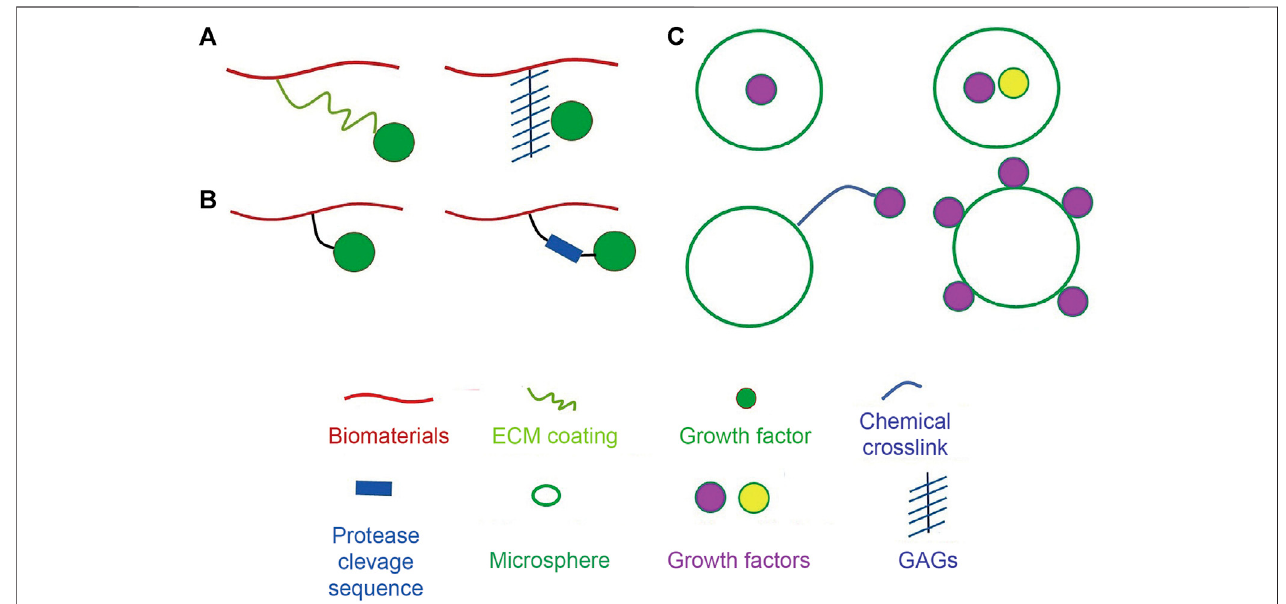
FIGURE 2 | Strategies for attachment of bioactive molecules to biomaterials. (A) Strategies to non-covalently attach bioactive molecules to biomaterials using physical tools. Bioactive molecules can be absorbed on the surface of the biomaterial through coating ECM proteins or can be electrostatically associated with biomaterials via heparin linkage. (B) Strategies to covalently attach bioactive molecules using chemical tools. Protease-degradable amino acids sequences can be introduced into crosslinks to instruct release of signaling cues. (C) Methodologies for incorporation of bioactive molecules to microspheres. Bioactive molecules can be encapsulated, adsorbed on the surface, or chemically linked to the microspheres. Adapted with permission from (Sha fi q et al., 2016). Copyrights reserved Elsevier.